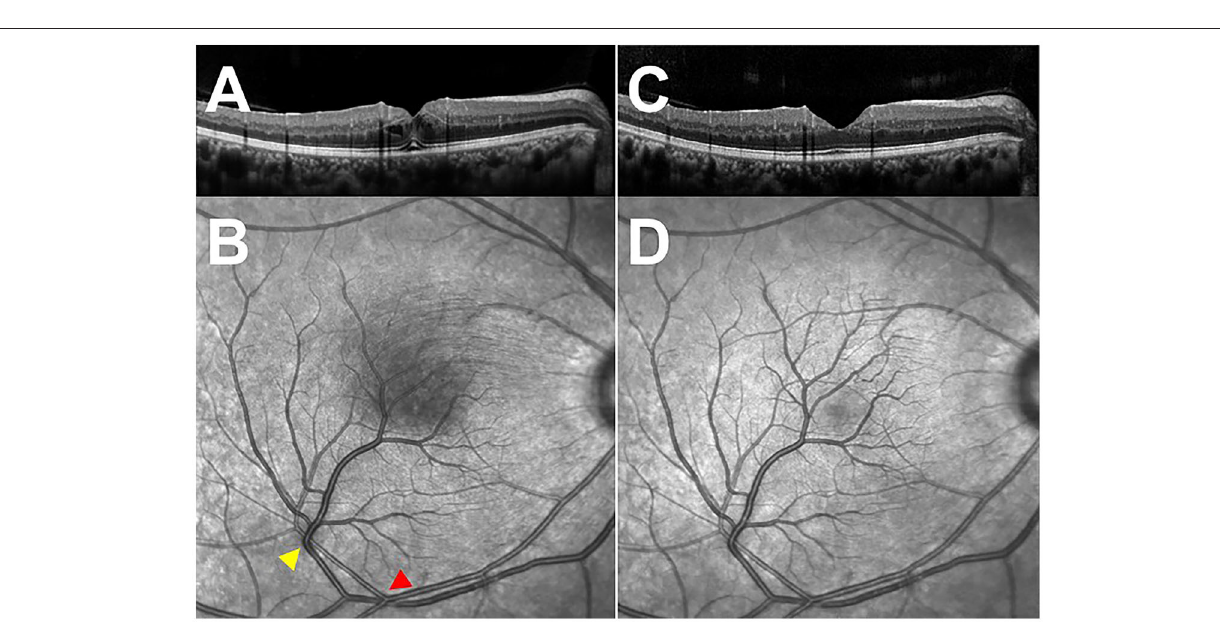
FIGURE 3 | Optical coherence tomography (OCT) through the fovea and infra-red images of the macula. (A) Initial OCT of the right eye, demonstrating cystoid macular edema. (B) Infra-red image of the macula, showing the sites of arteriovenous impression (arrowheads) and the shadow of the swollen never-fiber layer on retinal pigment epithelium (RPE). (C) OCT of the right eye at 2-week follow-up visit, revealing the absorption of macular edema. (D) Infra-red image of the macula at a 2-week follow-up visit, exhibiting the disappearance of the